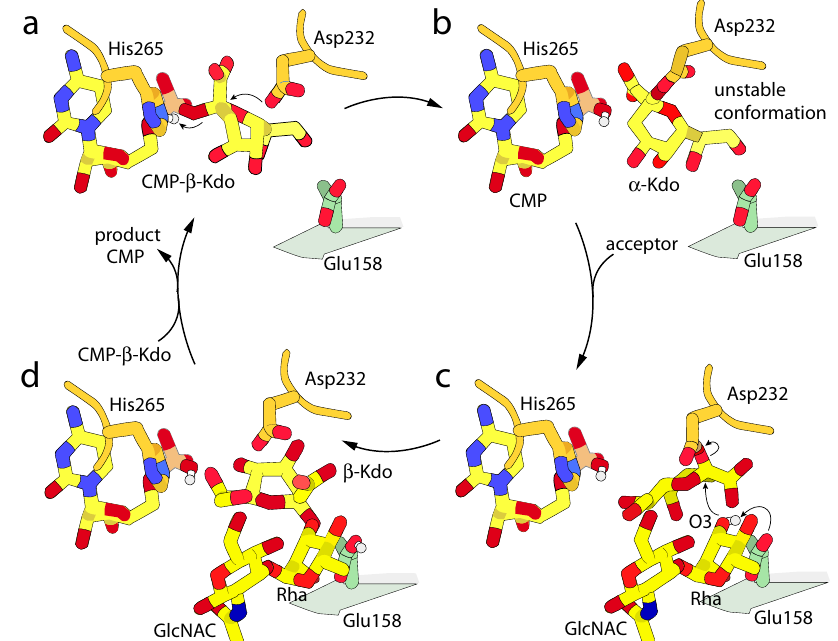
Fig.6|ProposedmechanismforWbbB GT99 retaining β -Kdotransferase.a CMP- β -Kdobindsintheactivesite.Asp232carboxylateperformsanucleophilicattackon the anomeric carbon, while a proton is transferred from His265 to the leaving phosphategroup. b Immediateproductofthe fi rsthalfreaction.Thisconformation has not been directly observed and is assumed to be unstable and short-lived. c Reorganized Asp232 – α -Kdo intermediate complex. While the acceptor can bind to the empty active site, the additional interactions mediated by Asp232 – α -Kdo